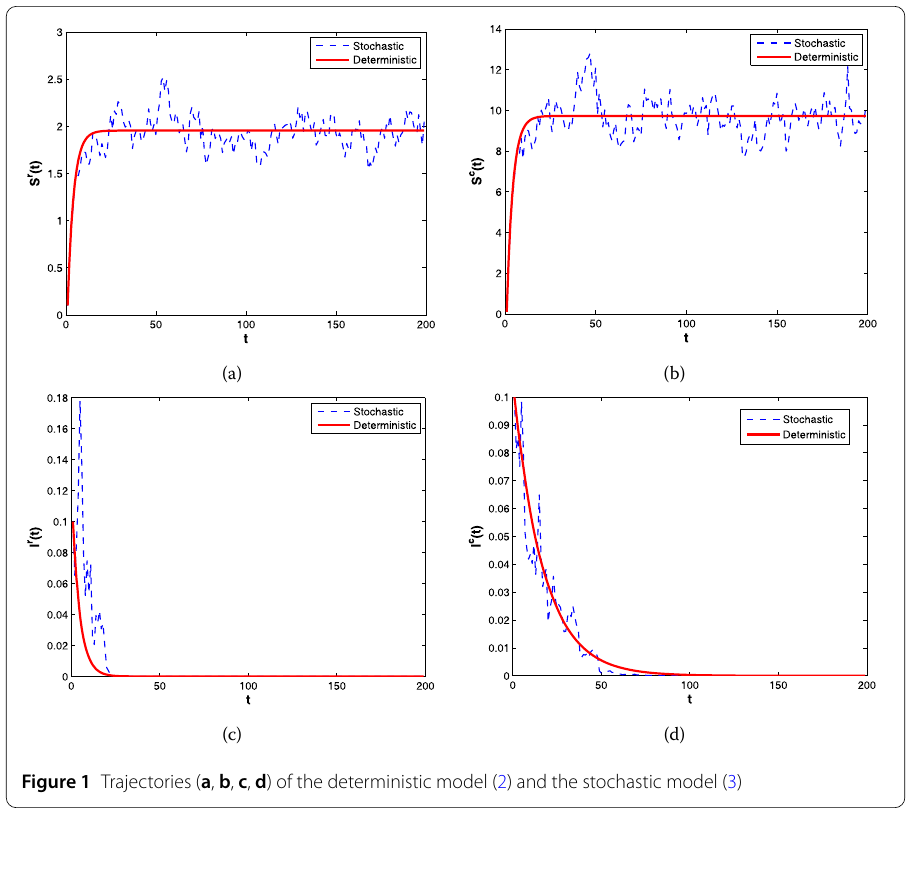
Figure 1 Trajectories ( a , b , c , d ) of the deterministic model (2) and the stochastic model (3)